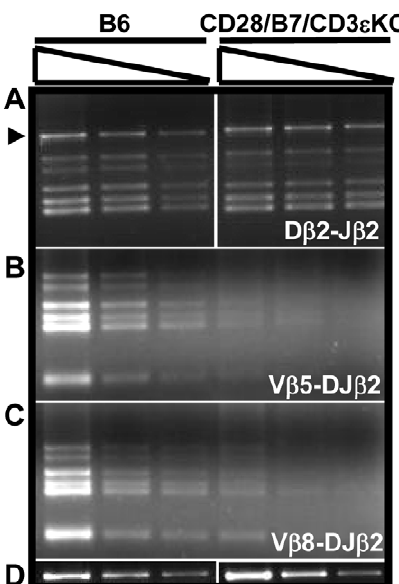
Figure 4. CD28/B7-dependent development permits D b 2-J b 2 rearrangement but substantially inhibits V-DJ b 2 rearrange- ment in DP thymocytes. 100, 30, and 10 ng of DNA prepared from FCM sorted DP cells was analyzed by PCR to detect (A) D b 2-J b 2 rearrangements, (B) V b 5-DJ b 2, or (C) V b 8.1-DJ b 2 rearrangements. The PCR for unrearranged IgM, the loading control, was performed using 10, 3, and 1 ng of DNA (D). The results shown are representative of three experiments performed using DNA prepared from five to six B6 or CD28/B7/CD3eKO mice.